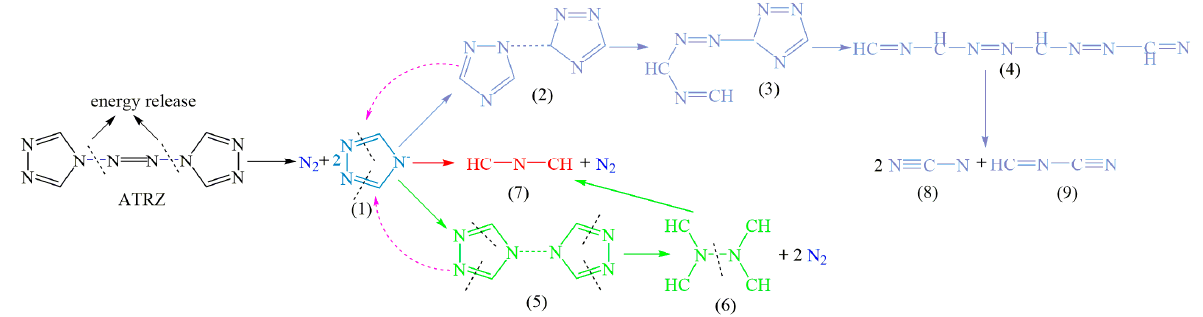
Figure 11. The concise pyrolysis pathway of ATRZ.